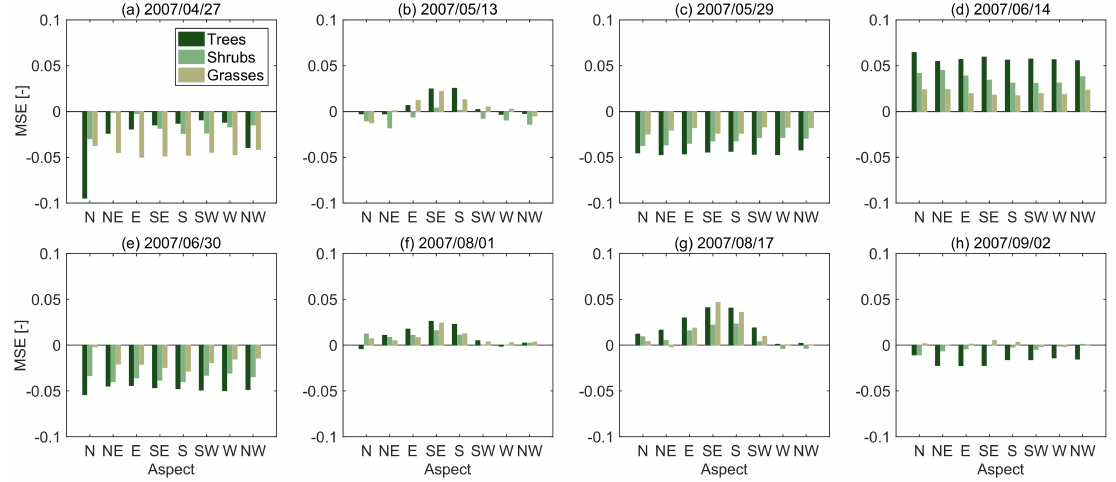
Figure 7. Mean signed error (MSE) separated by dominant vegetation functional type and aspect over the 2007 growing season at Dry Creek Experimental Watershed (DCEW), Idaho, USA for ( a ) 27 April 2007, ( b ) 13 May 2007, ( c ) 29 May 2007, ( d ) 14 June 2007, ( e ) 30 June 2007, ( f ) 1 August 2007, ( g ) 17 August 2007, and ( h ) 2 September